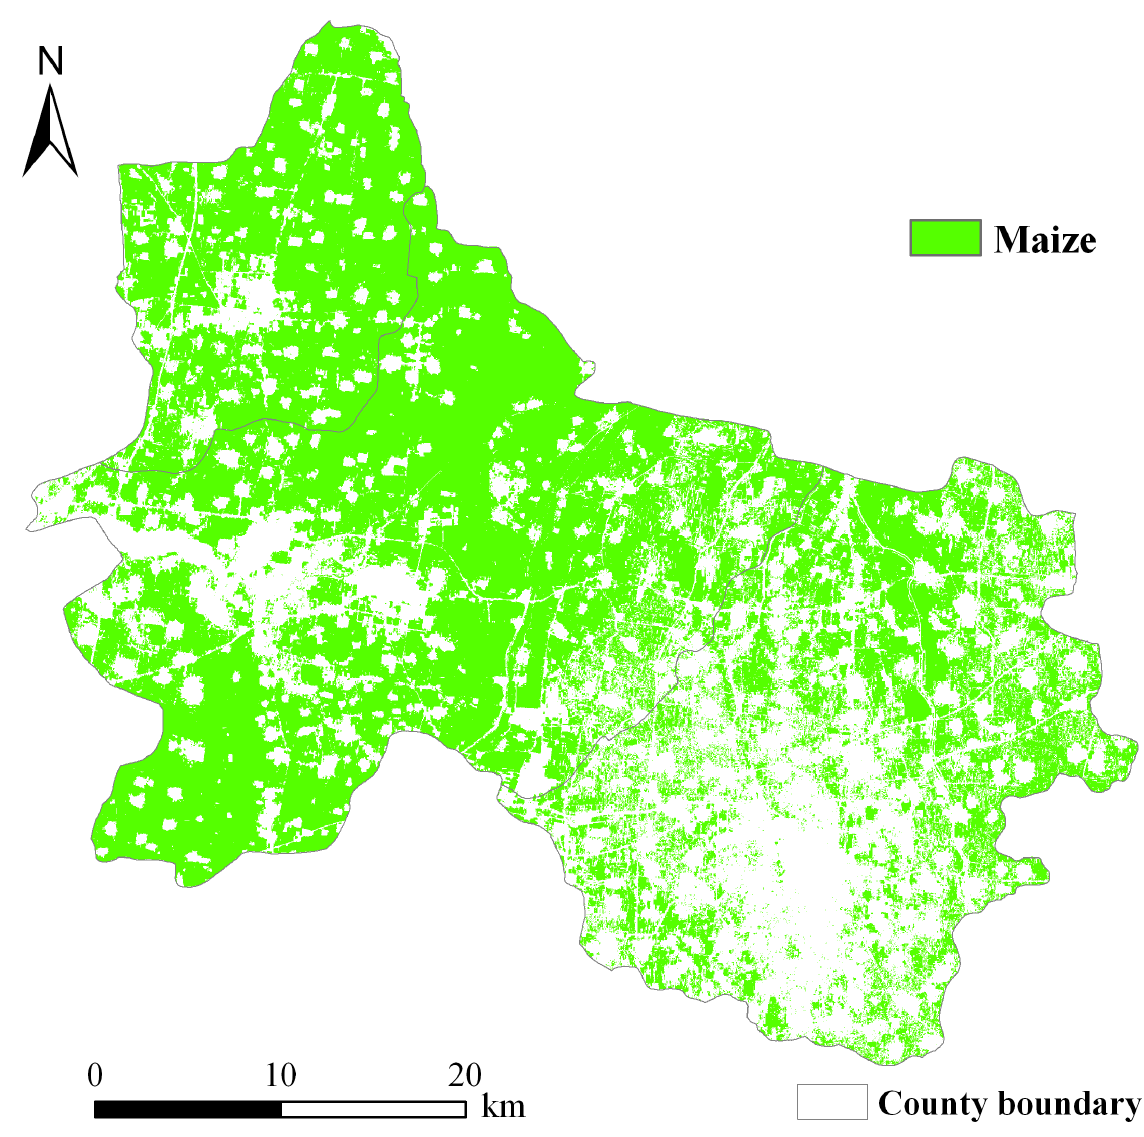
Figure 3. Maize classification map in three counties in North China.